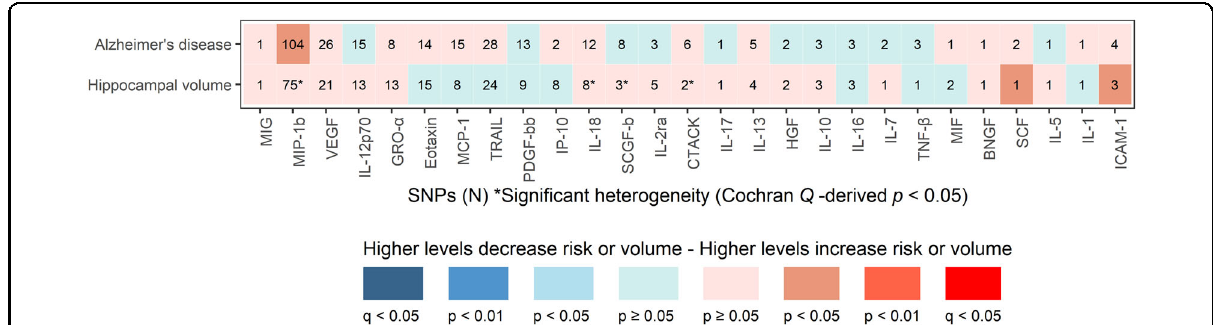
Fig. 2 Secondary Mendelian randomization associations of circulating cytokines and growth factors with Alzheimer ’ s disease and hippocampal volume. Shown are the results derived from the secondary inverse variance-weighted meta-analysis. None of the immune traits survived the multiple testing threshold of false discovery rate < 5% ( q < 0.05). BNGF, β -nerve growth factor; CTACK, cutaneous T-cell-attracting chemokine; GRO- α , growth-regulated oncogene α ; HGF, hepatocyte growth factor; ICAM-1, intercellular adhesion molecule 1; IL, interleukin; IP-10, interferon γ -induced protein 10; MCP-1, monocyte chemoattractant protein-1; MIF, macrophage migration inhibitory factor; MIG, monokine induced by γ -interferon indicates; MIP-1b, macrophage in fl ammatory protein-1 β ; PDGF-bb, platelet-derived growth factor-bb; SCF, stem cell factor; SCGF-b,